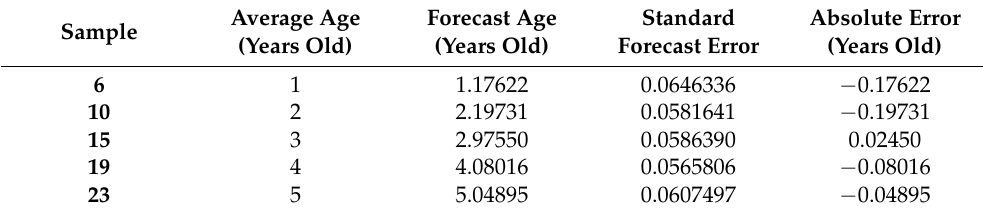
Table 11. Validation of the F5 model with five of the analyzed Fino